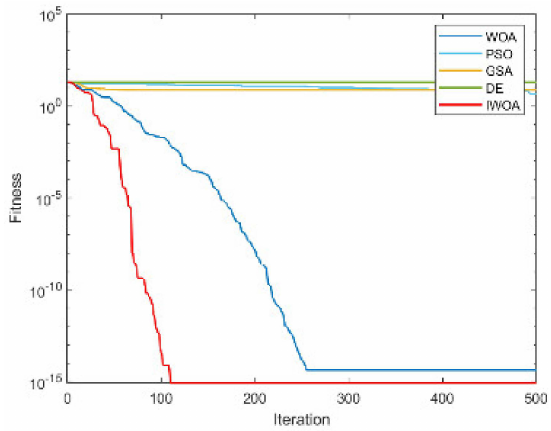
Figure A6. The convergence curve for solving F6.